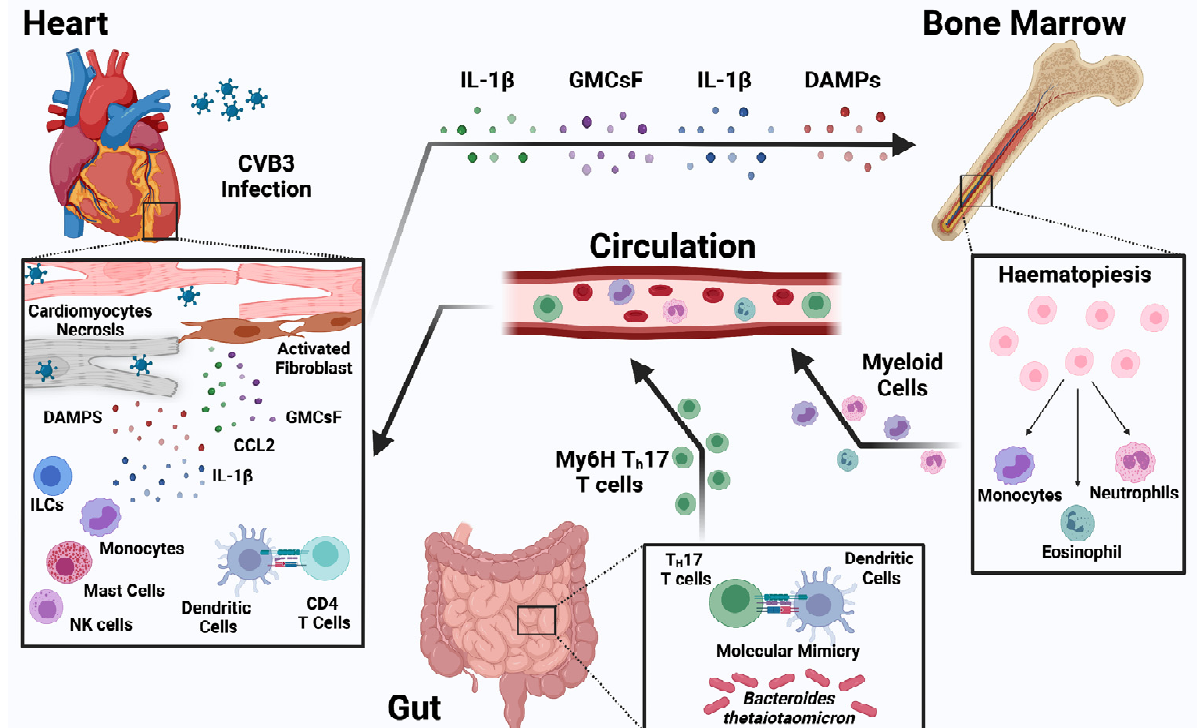
Figure 3. Immune regulation of coxsackievirus B3-induced myocarditis. Coxsackievirus B3 has the ability to infect cardiomyocytes. The innate immune system including ILCs, NK cells, macrophages, and dendritic cells in the heart is activated after the release of damage-associated molecular patterns (DAMPs). Cardiac stroma cells such as fibroblasts are also activated. Together with the immune cells, they release chemokines and cytokines that attract other immune cells from circulation. In addition, bone marrow is activated and increases hematopoiesis by the heart-derived mediators such as IL-1 β , GM-CSF, and DAMPs. The gut is a possible other source of inflammatory cells such as Th17 cells that could have been primed by gut microbiota.